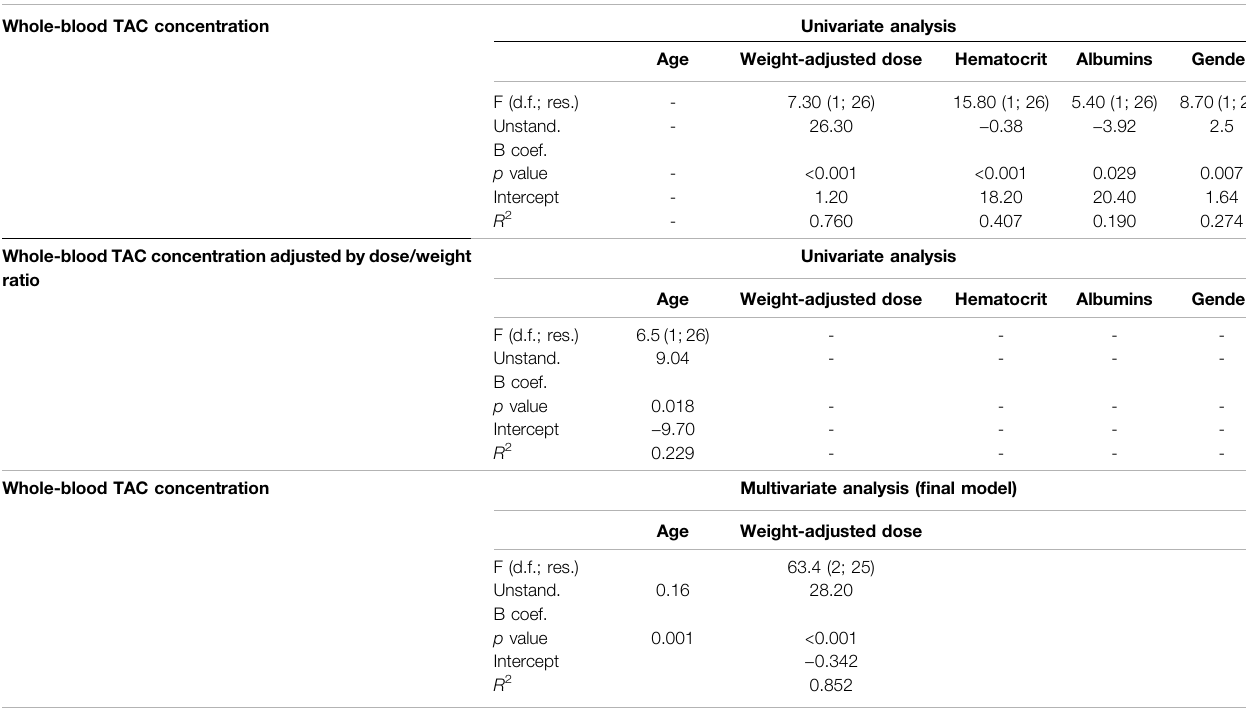
TABLE 3 | Report of the univariate and multivariate regression analysis for the prediction of TAC concentrations in WB. All the statistics have been reported in APA format.